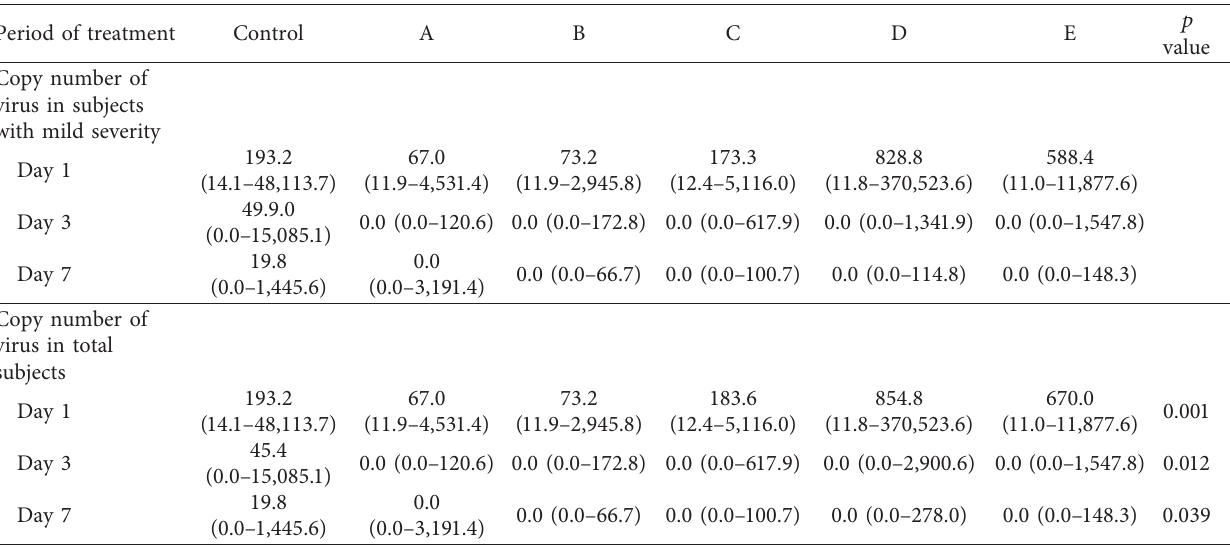
Table 3: The results of the copy number of the virus of Control and treatment groups were analyzed in subjects with mild severity and total subjects evaluated using qRT-PCR on treatment days 1, 3, and